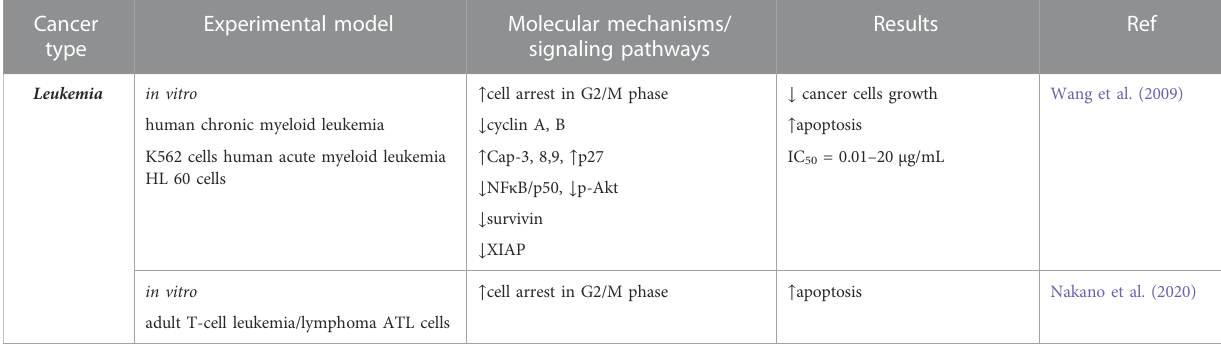
TABLE 1 ( Continued ) Summarized data obtained from preclinical pharmacological studies regarding calotropin anticancer